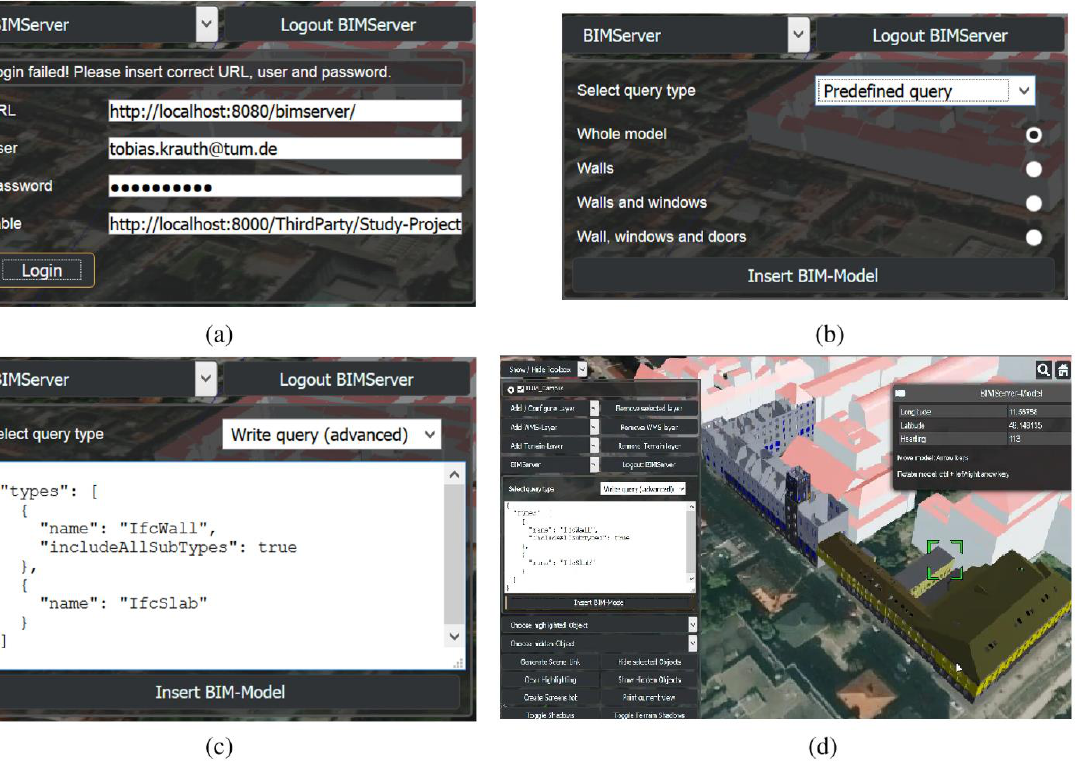
Figure 8: Four different states of the BIMserver panel inside the 3D web client, when a login failed (a), after the login with "Predefined query" selected (b), after the login with custom query selected (c), BIM model successfully inserted into city model (d) information about attributes is displayed, but instead the geodetic coordinate of the point of origin of the glTF model. If the model is moved using the arrow keys (section 3.2), the coordinates shown in the attribute display will also change. In addition, instructions for moving the model are also displayed.